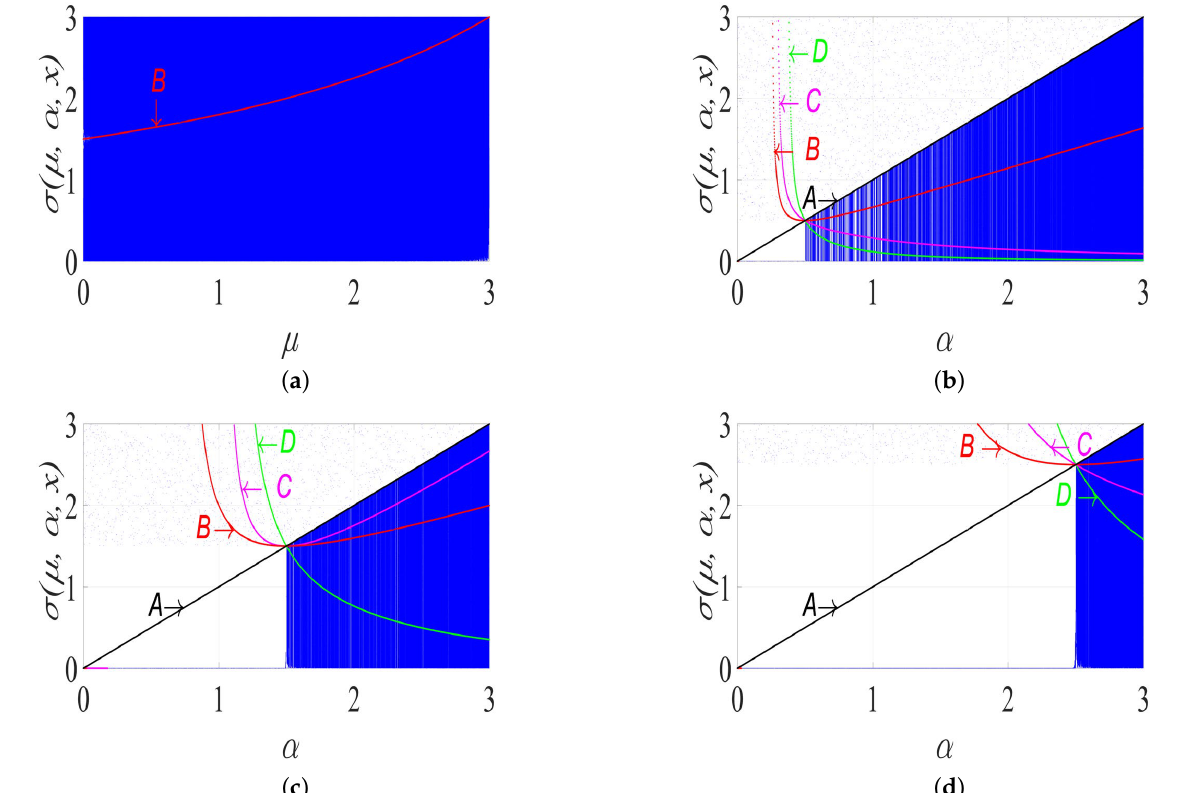
Figure 2. Bifurcation diagram of the STM: ( a ) µ ∈ (0, 3.0) and α = 3.0, ( b ) α ∈ (0, 3.0) and µ = 0.5, ( c ) α ∈ (0, 3.0) and µ = 1.5, and ( d ) α ∈ (0, 3.0) and µ = 2.5. Red and black lines show the fixed points, and green and magenta lines show the conditions for periodic